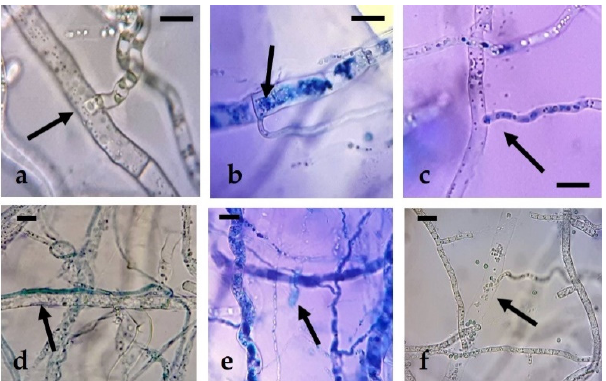
Figure 1. Hyphal interactions of T. harzianum with N. parvum in dual plate confrontations: ( a – c ): penetration structures; ( d ) appressorium; ( e ) papilla-like structures; ( f ) hyphal lysis. Bars = 10 µm.